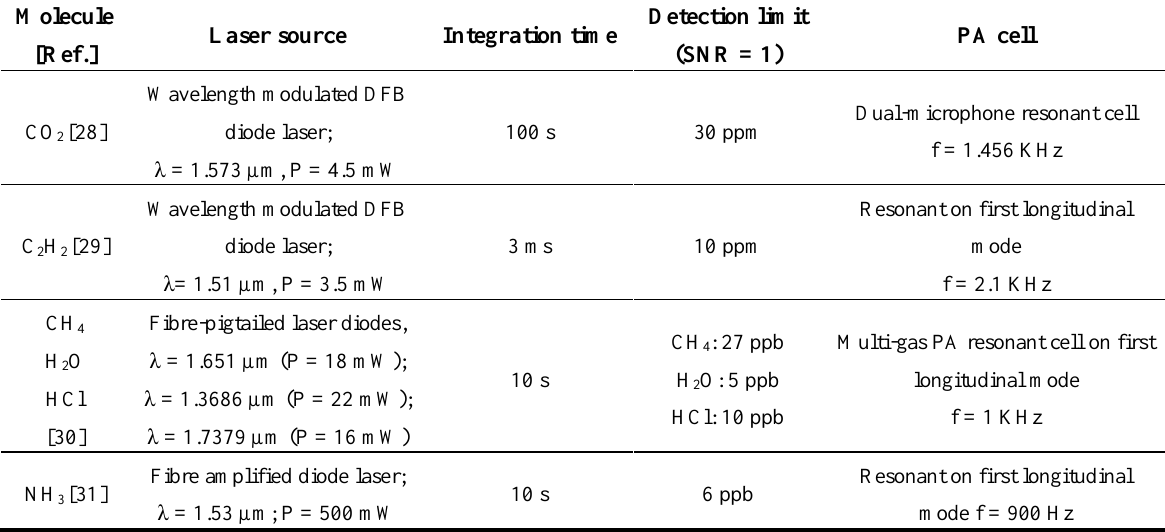
Table 1. PA detection of trace gases with NIR diode